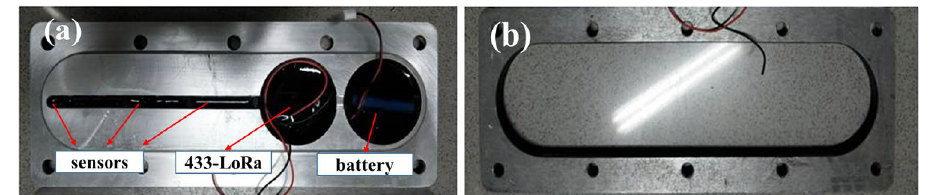
Figure 4. Sensor structure installed in the field: ( a ) Sensor body, ( b ) Sensor base.